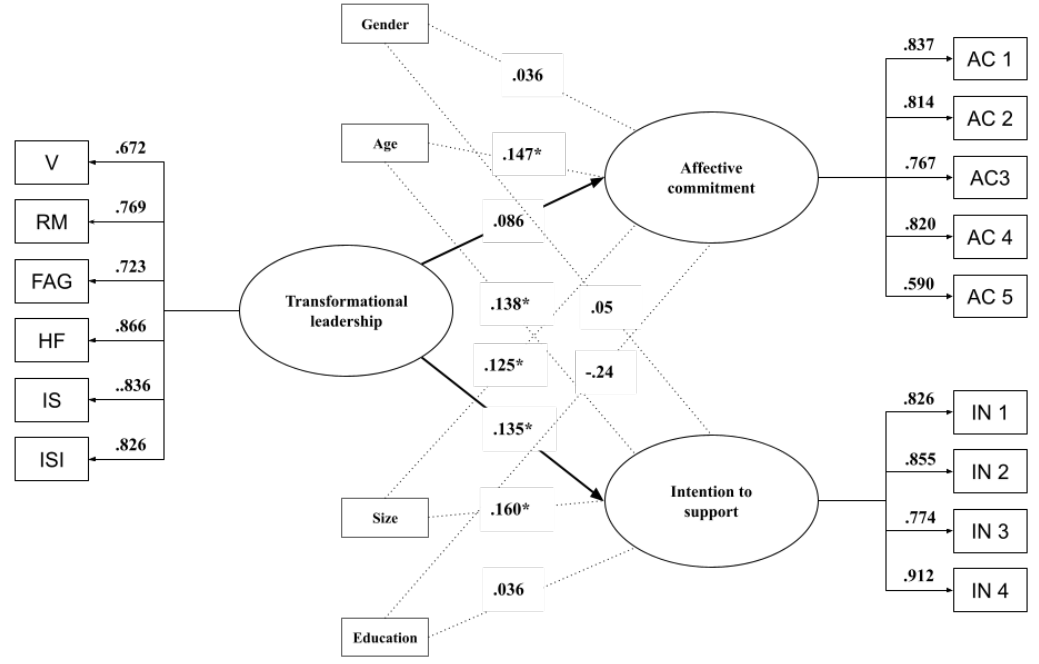
Figure 2. Direct effects (Model